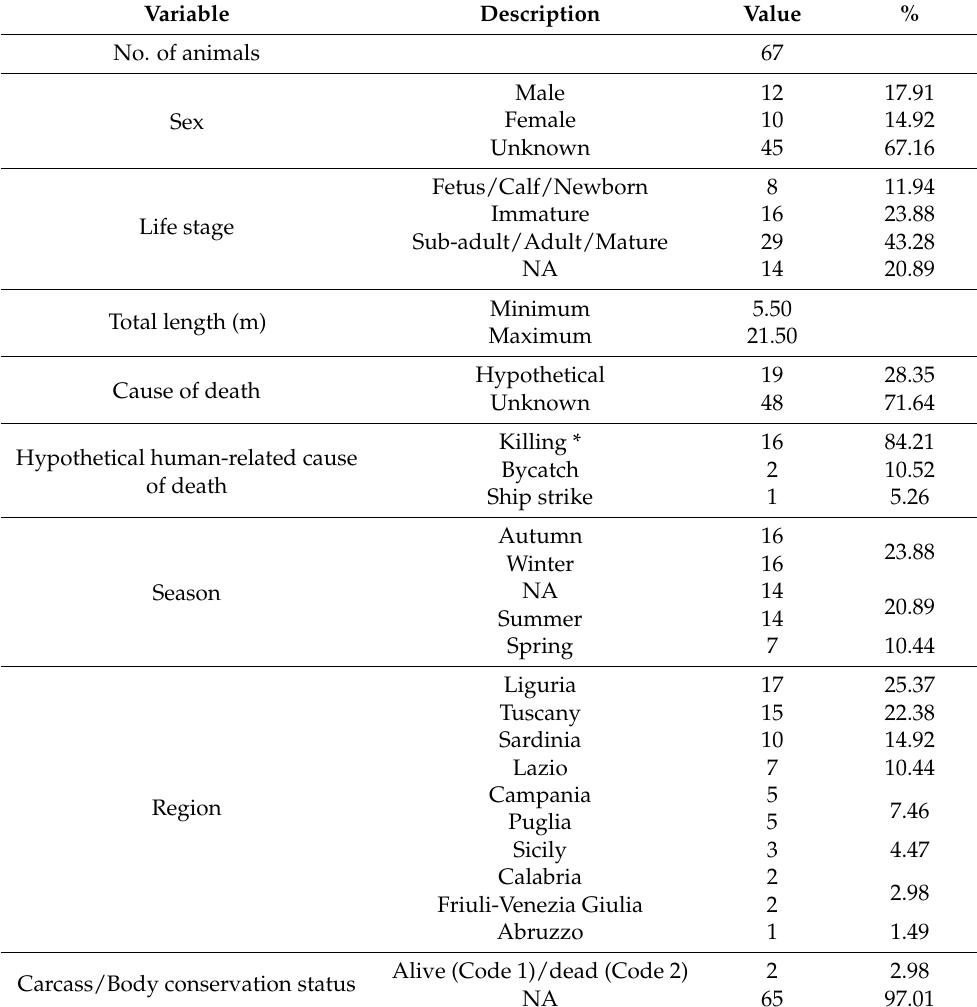
Table 1. Summary of the main variables of historical mortality events (1624–1963). N/A Not available, (*) Here, the cause of death is